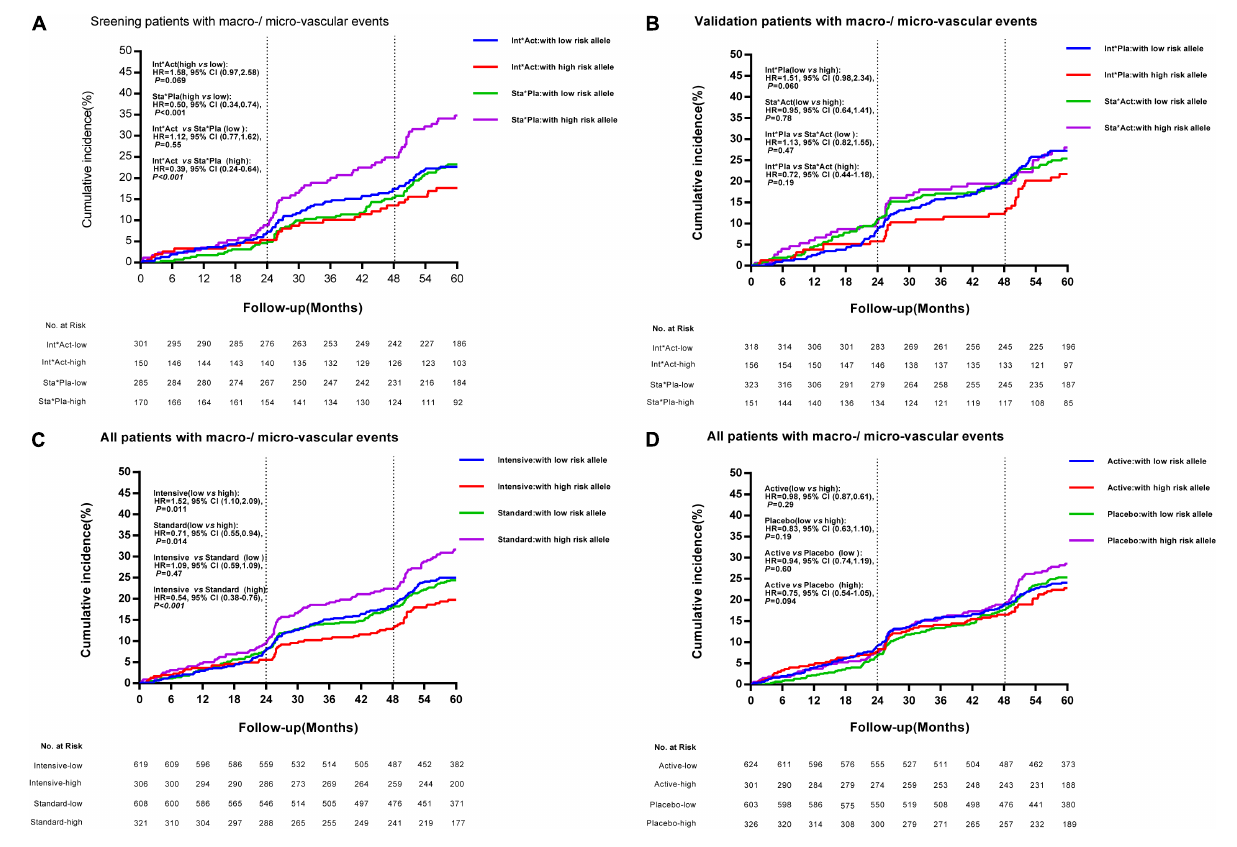
FIGURE 3 | Cumulative incidence of combined major macrovascular and microvascular events among individuals with high- and low-risk alleles according to treatment strategies. Panel (A) depicts the cumulative incidence of combined major macrovascular and microvascular events in the screening stage (patients receiving combined intensive [Int] and active [Act] treatment, versus patients receiving combined standard [Sta] and matched placebo [Pla] treatment) among individuals with high-risk and low-risk alleles. Panel (B) represents the cumulative incidence of combined major macrovascular and microvascular events in the validation cohorts (patients receiving combined Int and Pla treatment, versus those receiving combined Act and Sta intervention) among individuals with high-risk and low-risk alleles. Panels (C,D) show the cumulative incidence of combined major macrovascular and microvascular events among individuals with high-risk and low-risk alleles according to glucose control and blood pressure-lowering